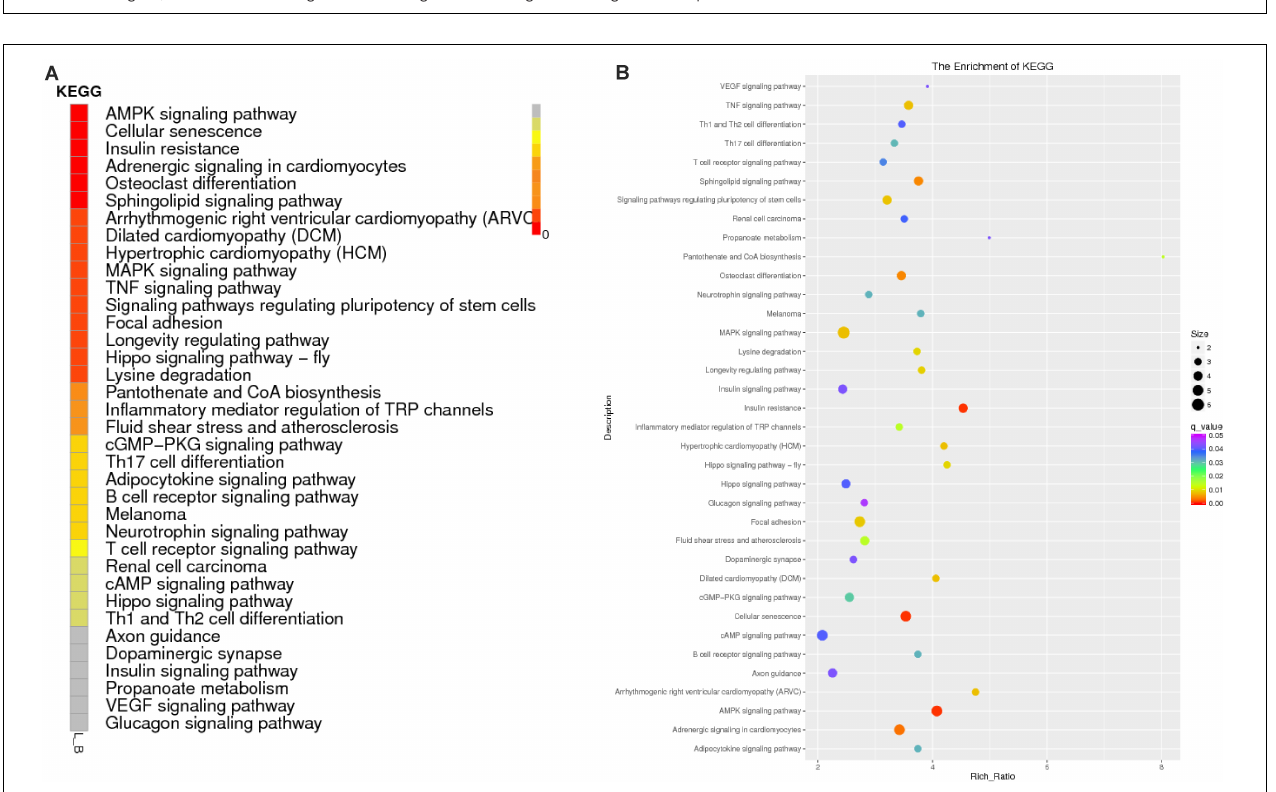
FIGURE 6 | Enrichment results of the KEGG analysis. (A) Enrichment path Q -value distribution map, in which the vertical coordinate is the KEGG pathway entry, horizontal coordinate is the name of the sample, and different colors represent different enrichment degrees; (B) KEGG enrichment Q -value results for single groups, whereby each point represents the enrichment degree of the KEGG entry, and the closer the color is to red, the higher the enrichment degree. The size of each point indicates the number of genes enriched in the KEGG entry, and the larger the point is, the more genes enriched in the KEGG entry, and vice versa.